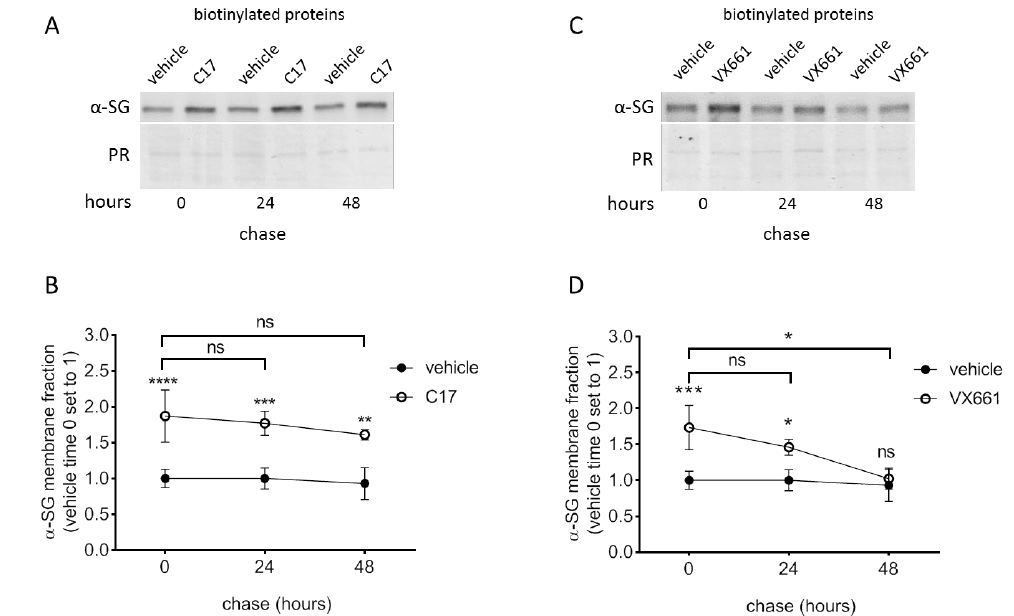
Figure 6. The rescued α -SG protein is stable at the plasma membrane. Myogenic cells from a patient carrying the L31P / V247M α -SG mutations were di ff erentiated for 7 days and treated for the last 78 h with either 1% (cid:24) DMSO (vehicle), C17 15 µ M or VX661 25 µ M. At the end of treatment, corrector-containing medium was removed and replaced with fresh medium. Myotubes were then treated and lysed as described in the legend of Figure 2 at the indicated time points. Representative western blots of the biotinylated membrane fraction from myotubes treated with vehicle or C17 ( A ); with vehicle or VX661 ( C ) probed with antibodies specific for α -SG, Ponceau Red (PR) staining is reported to estimate protein loading. The content of α -SG resident in the sarcolemma of cells pre-treated with C17 ( B ) or VX661 ( D ) was quantified by densitometric analysis of 4 independent experiments. Mean values ( +/ − SD) are referred to the amount of α -SG present in vehicle-treated cells at time 0. Statistical analysis was performed by One-way ANOVA test followed by multiple comparisons Tukey’s test; ns, p > 0.05; *, p ≤ 0.05; **, p ≤ 0.01; ***, p ≤ 0.001; ****, p ≤